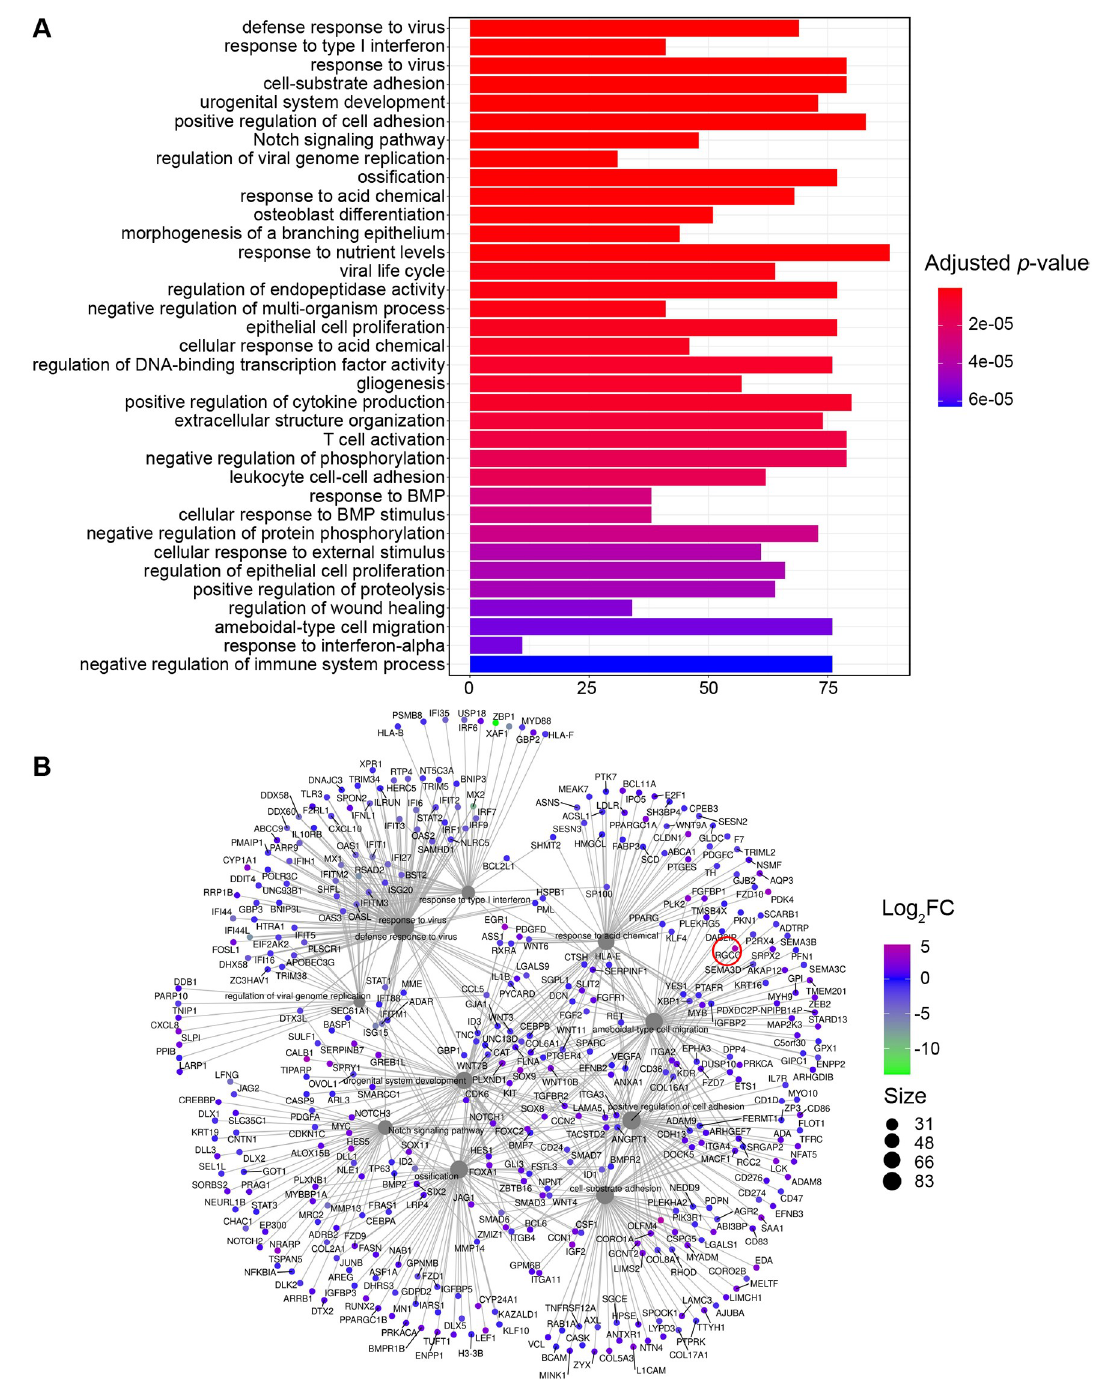
Fig 3. Transcriptomic responses of TIGKs to challenge with P . gingivalis . A) GO term classifications of pathways containing significant numbers (as denoted below figure) of differentially regulated genes in TIGK cells challenged with P . gingivalis . B) String analysis of differentially regulated genes in the GO term of ameboidal-type cell migration. RGCC is highlighted with a red circle.